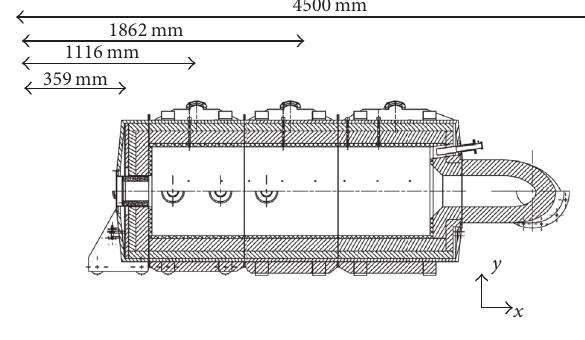
Figure 1: Furnace configuration.